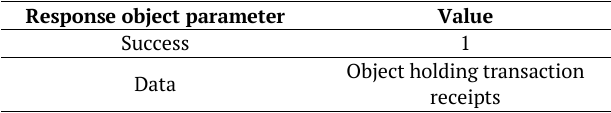
Table 2. Successful json response